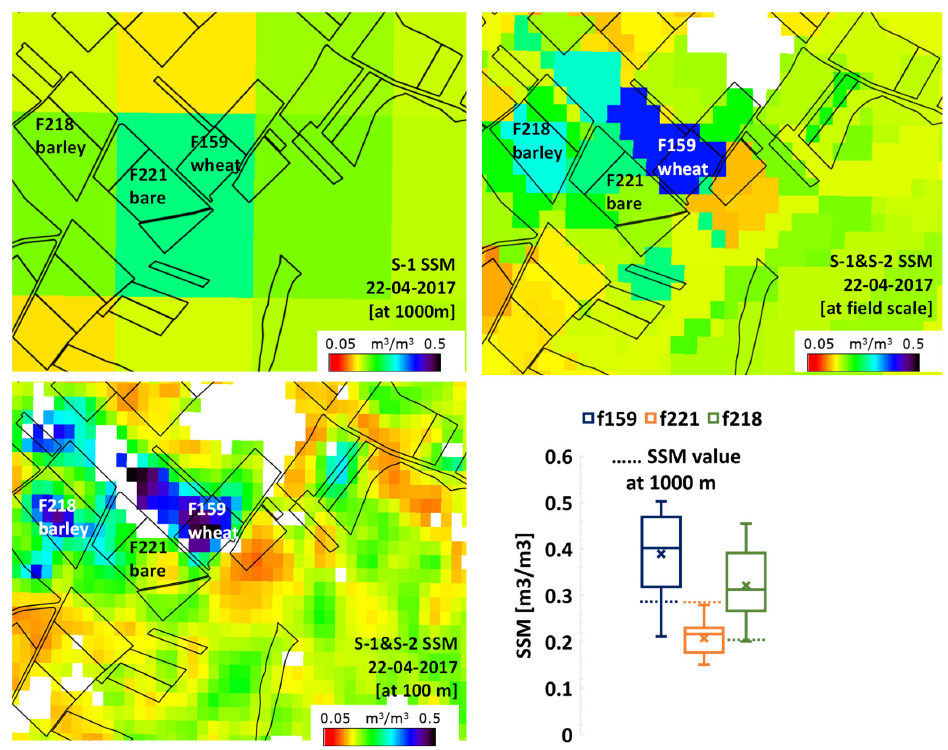
Figure 6. View over the Riaza irrigation district in Spain. Field borders are in black. White areas are masked for roughness or local vegetation changes. Top row : S ‐ 1 SSM map at 1000 m, i.e., 520 m pixel ( left panel ) and at field scale ( right panel ) on 22 April 2017 (EPSG: 4326, WGS 84). Bottom row : SSM map at 100 m, i.e., 40 m pixel ( left panel ). Right panel : box plot of the SSM distributions of the irrigated fields, f159 and f218, and non ‐ irrigated field f221 at 100 m. Crosses represent the mean SSM value at field scale; dashed lines indicate the SSM level at 1000 m.